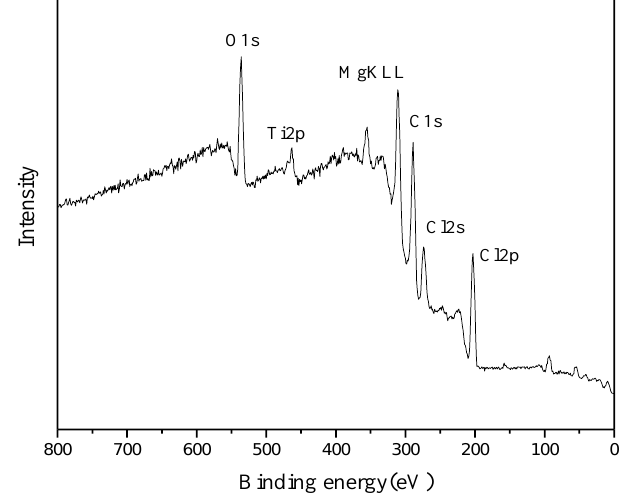
Figure 4. X-ray photoelectron spectroscopy (XPS) survey spectrum of Cat-3.